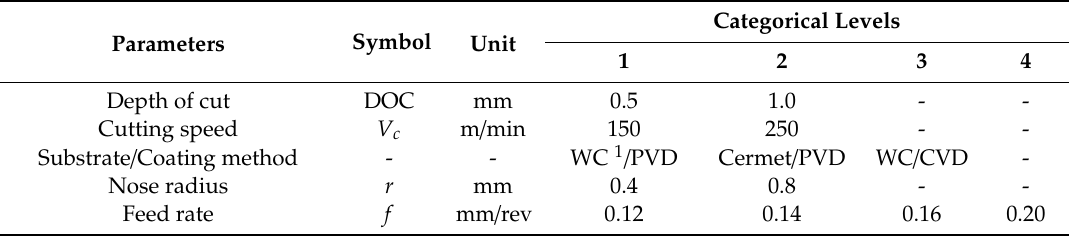
Table 1. Quantitative and qualitative controllable factors and respective mixed levels used for a full factorial